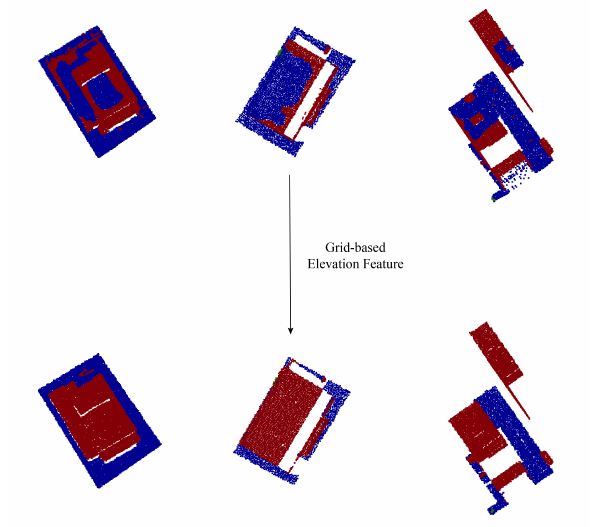
Figure 5. Corrections of grid-based elevation filter for constructions lacking corresponding ground points